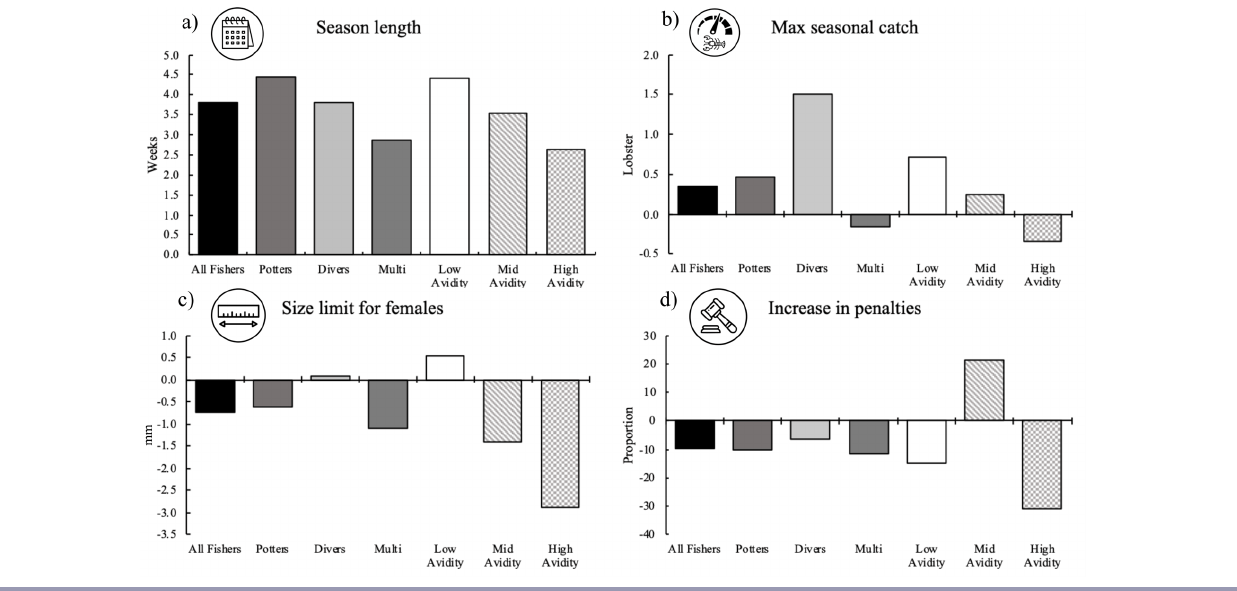
Fig. 7 . Trade-offs fishers are willing to make between a reduction in bag limit by one lobster and a change in (a) season length, (b) maximum seasonal catch, (c) minimum size limit for females, and (d) penalties for noncompliant acts. See Appendix 1, Table 4 for detailed